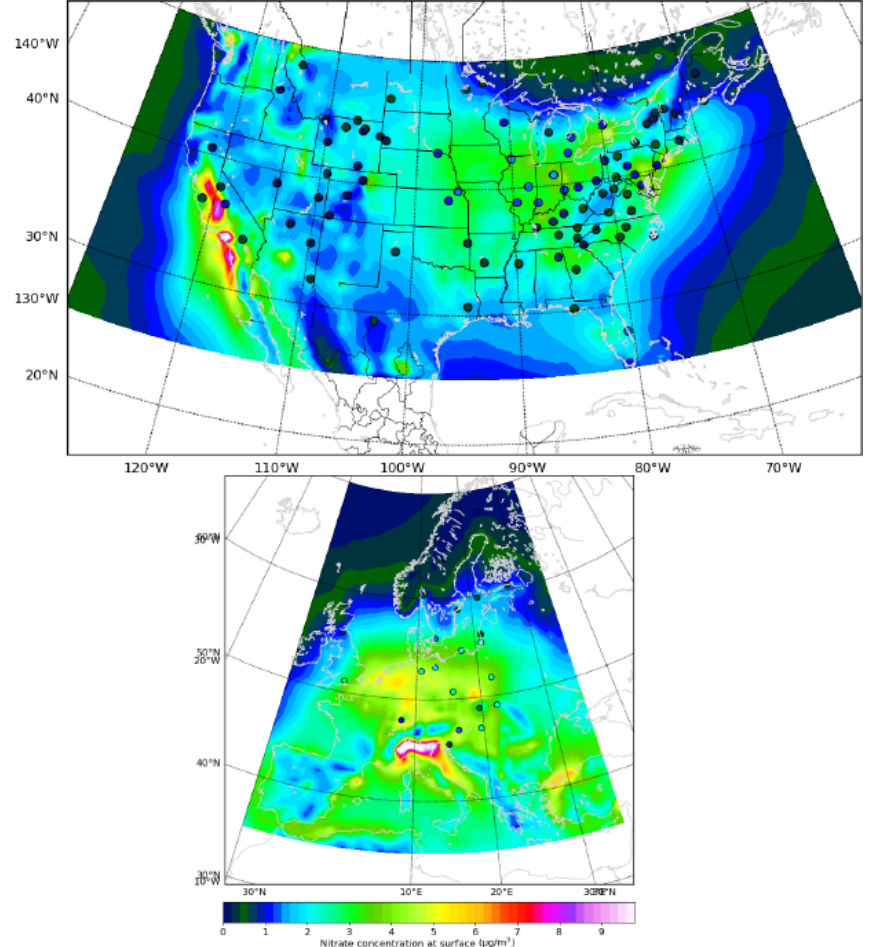
Figure 17. Mean 2017 surface nitrate concentration (in µgm − 3 ) simulated by IFS-AER CY47R1 against yearly average from the CASTNET and the EMEP networks (shown as black